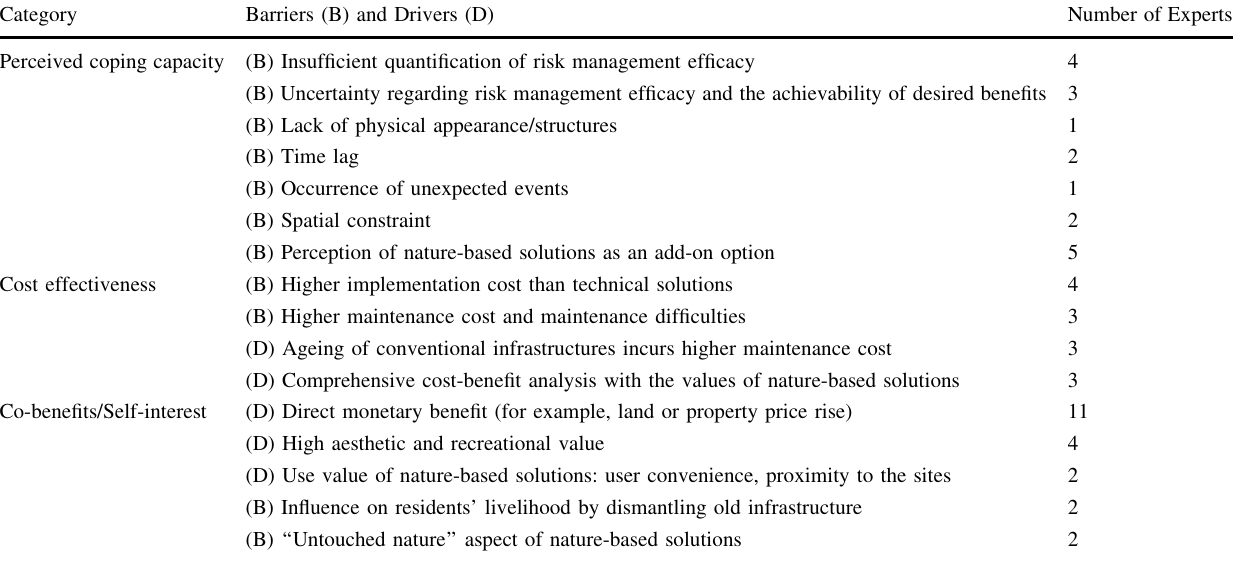
Table 3 Attitudinal barriers and drivers for mainstreaming nature-based solutions (NBS) in South Korea